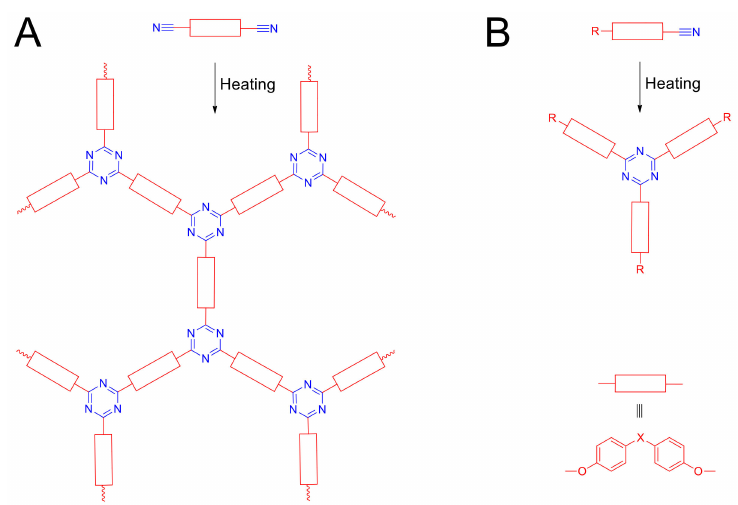
Figure 1. Schemes of polycyclotrimerization of dicyanate esters ( A ) and cyclotrimerization of monocyanate esters ( B ).